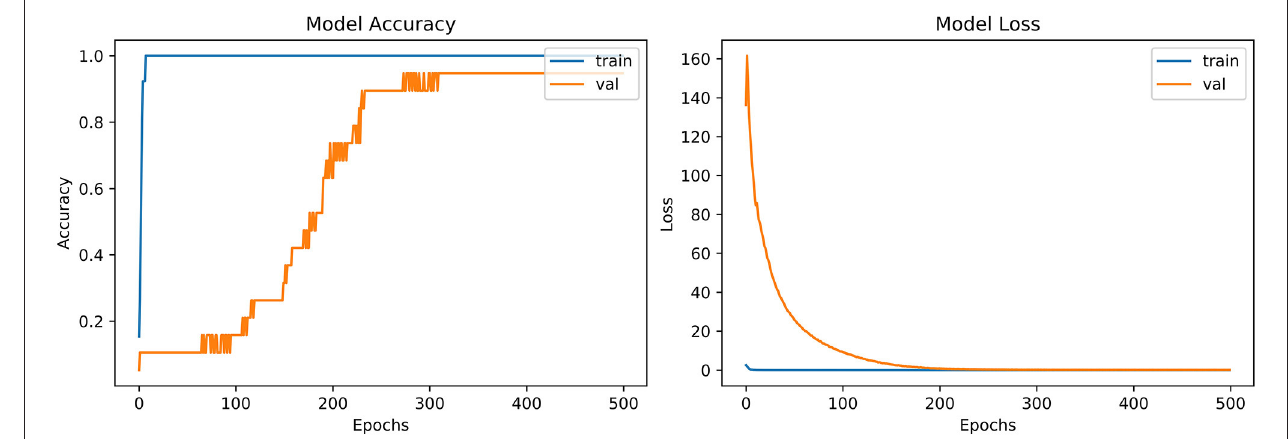
FIGURE 4 | Model accuracy and model loss for VGG-B3.